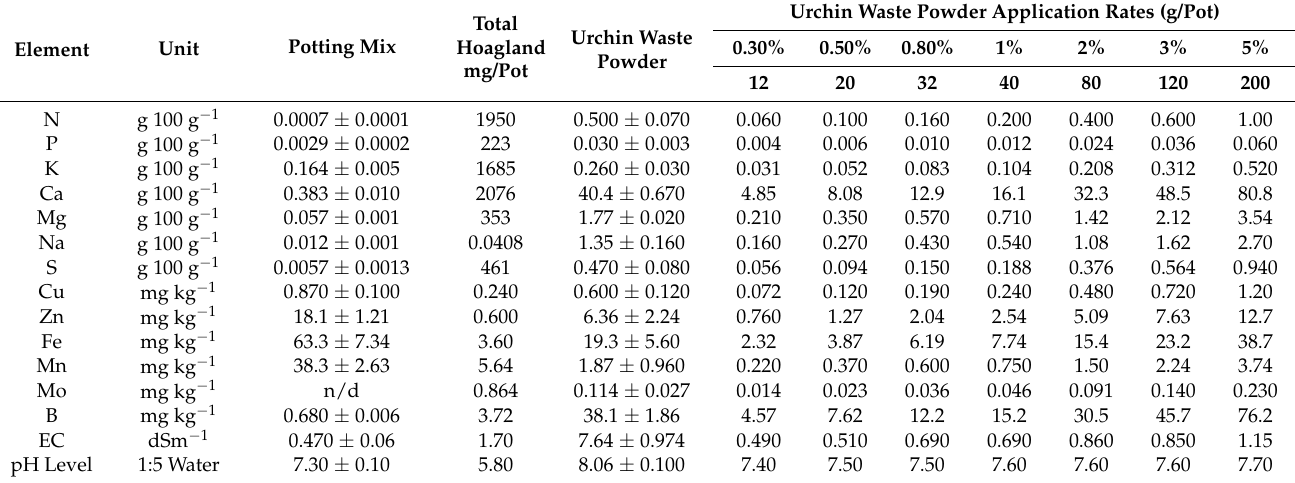
Table 1. Nutrient composition of the potting mix with UWP applied at different rates and the total applied in the Hoagland